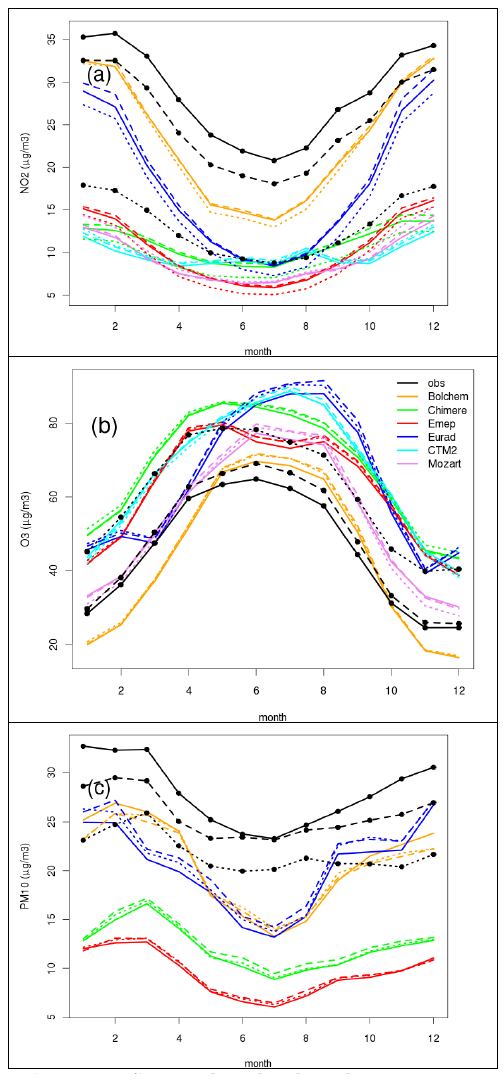
Figure 4 : Seasonal cycles based on 10 years of daily mean values for NO 2 (top), O 3 (middle), and PM10 (bottom) observed (black) and modelled by BOLCHEM (orange), CHIMERE (green), EMEP (red), EURAD (blue), OSLOCTM2 (cyan) and MOZART (violet). Solid lines for urban background, dashed: suburban, and dotted: rural AIRBASE stations.